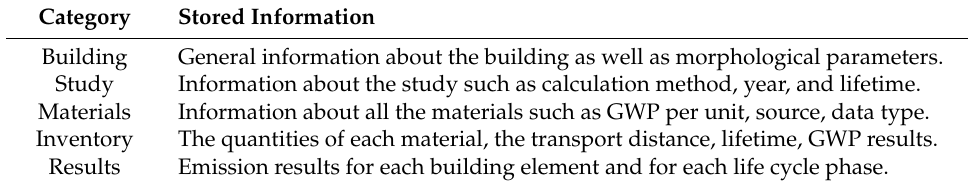
Table 1. The information that is stored in and can be reported by the bLCAd-tool. Detailed contents are listed in Figures 1 and A1.